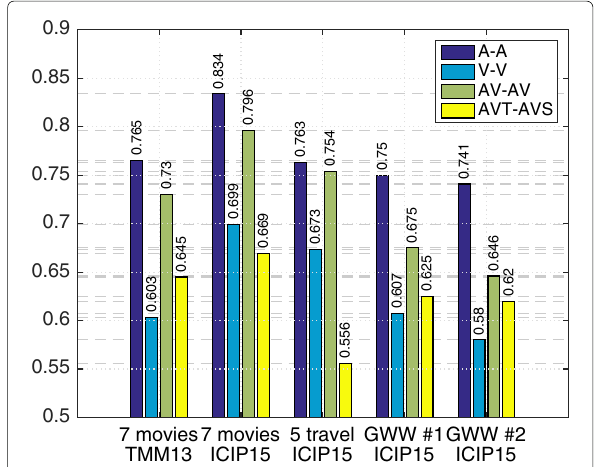
Fig. 14 Results overview over the COGNIMUSE database. Evaluation results using AUC (Area Under Curve) comparing all modalities and evaluation set-ups using the baseline TMM13 and the ICIP15 movie summarization